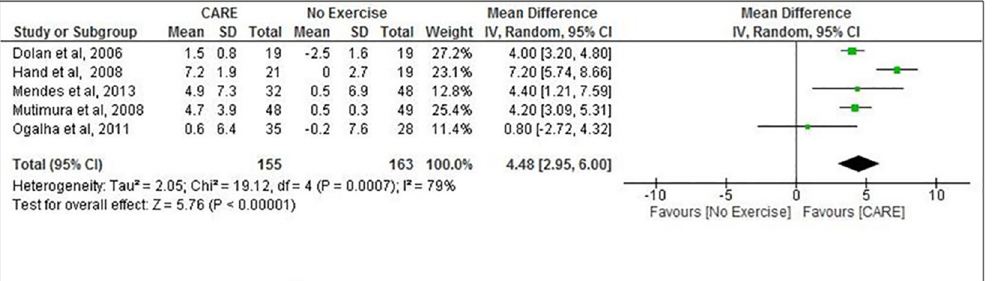
Fig 2. Combined aerobic and resistance exercise (CARE) versus No Exercise: Peak VO 2 . Review Manager (RevMan). Version 5.2 The Cochrane Collaboration,